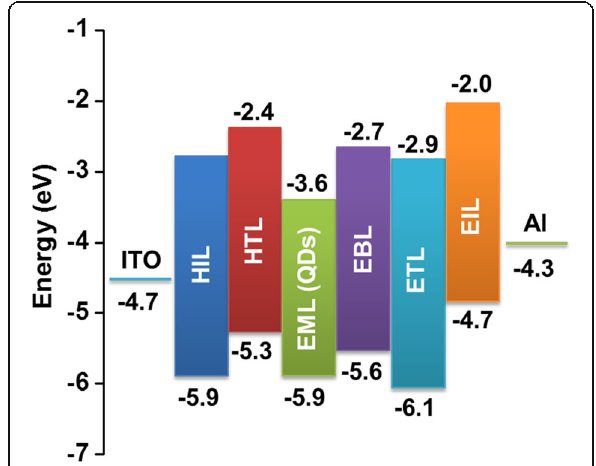
Fig. 5 The energy levels of the individual layers of multilayered InP/ ZnS core/shell QD-LEDs